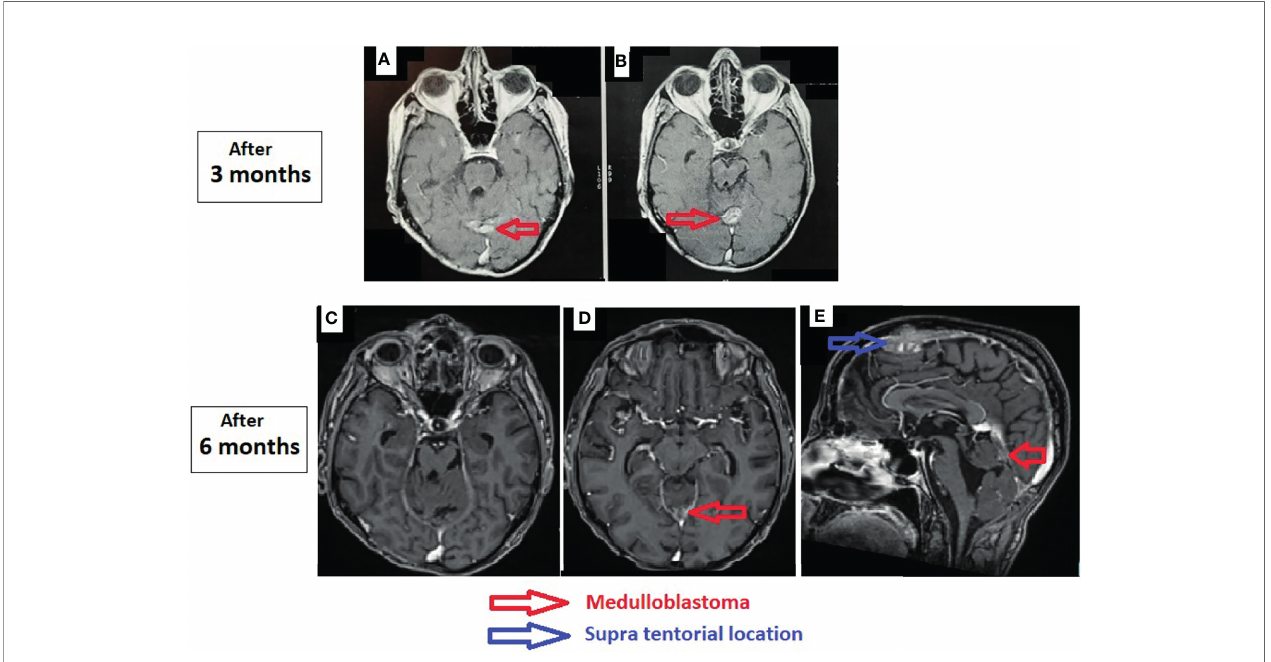
FIGURE 3 | Control magnetic resonance imaging of the brain. (A, B) After 3 months: axial T1-weighted post-gadolinium. (C – E) After 6 months: axial T1-weighted post-gadolinium (C, D) and sagittal T1-weighted post-gadolinium (E)